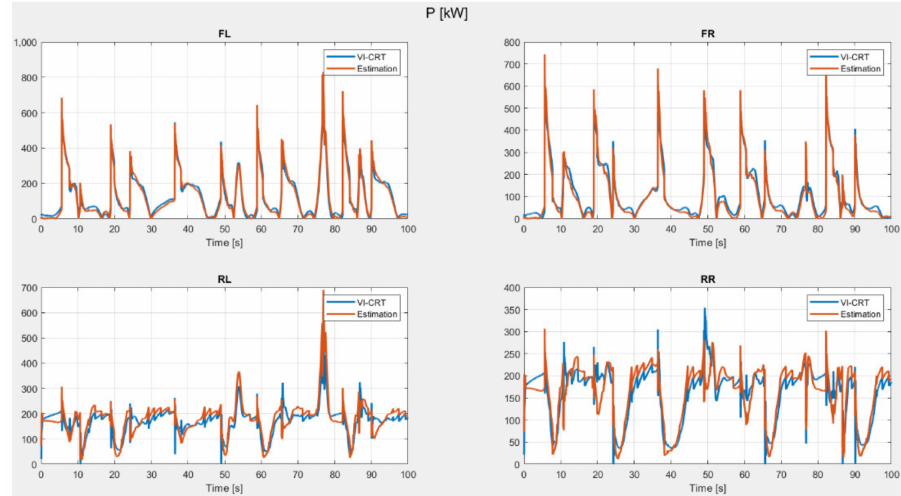
Figure 6. Total sliding power (P) developed by each